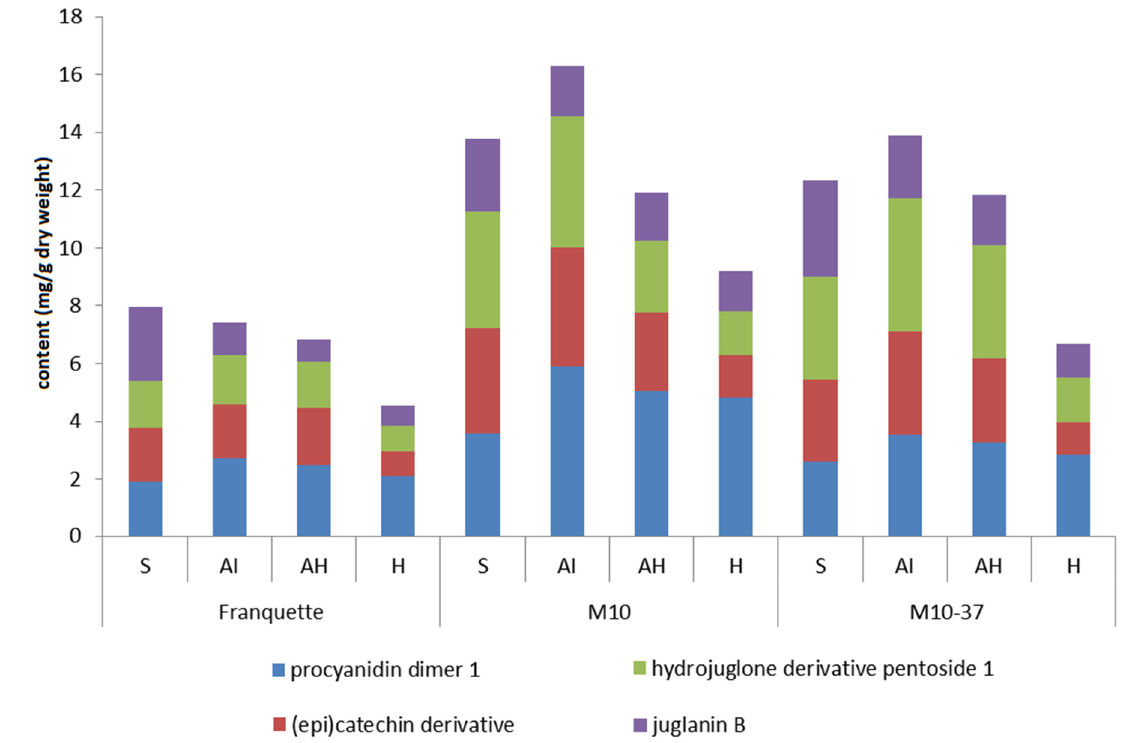
Figure 6. Contents of selected naphthoquinones and flavanols identified in different severity of walnut anthracnose-affected tissues of J. regia husk, between three cultivars: susceptible ‘M10-37’, semi-susceptible ‘M10’ and least susceptible ‘Franquette’ (in mg/g dry weight). S: inner spot of infected tissue; AI: outer margin of infected tissue; AH: healthy tissue surrounding the infection; H: healthy tissue.